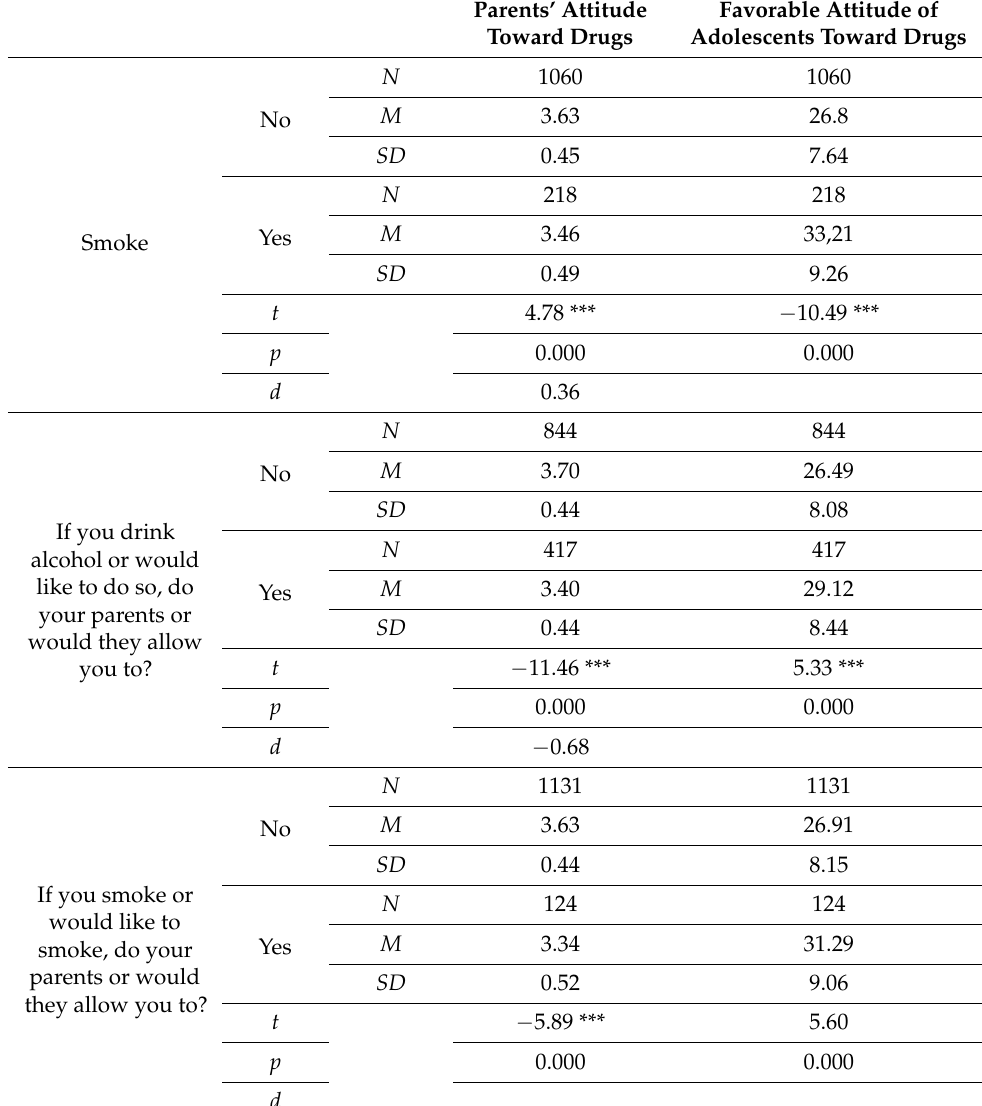
Table 5. Parents’ and adolescents’ attitudes toward drugs. Student’s t-test depending on whether they smoke or not (no/yes), permissiveness of parents toward drinking alcohol (no/yes) and smoking (no/yes). Parents’ Attitude Favorable Attitude of Toward Drugs Adolescents Toward Drugs N 1060 No